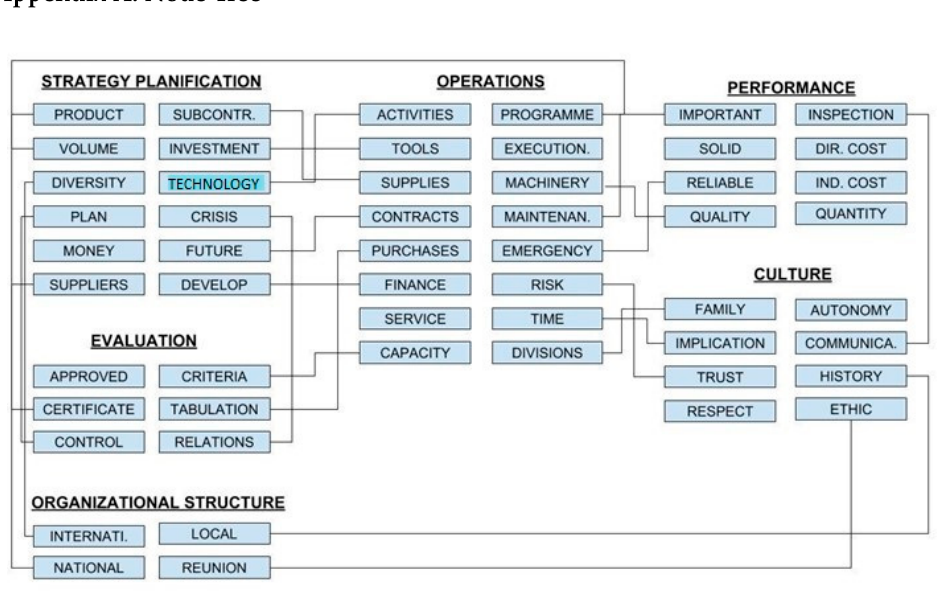
Figure A1. Node tree. Source: Authors.